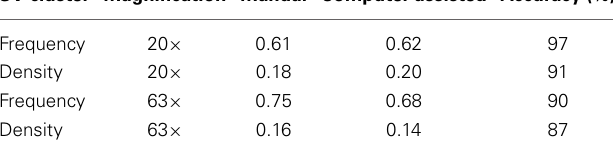
Table 1 | Comparison of SV cluster frequency and density obtained using manual vs. computer-assisted processing of low (20 × ) or high (63 × ) magnification images (number of overlap regions =